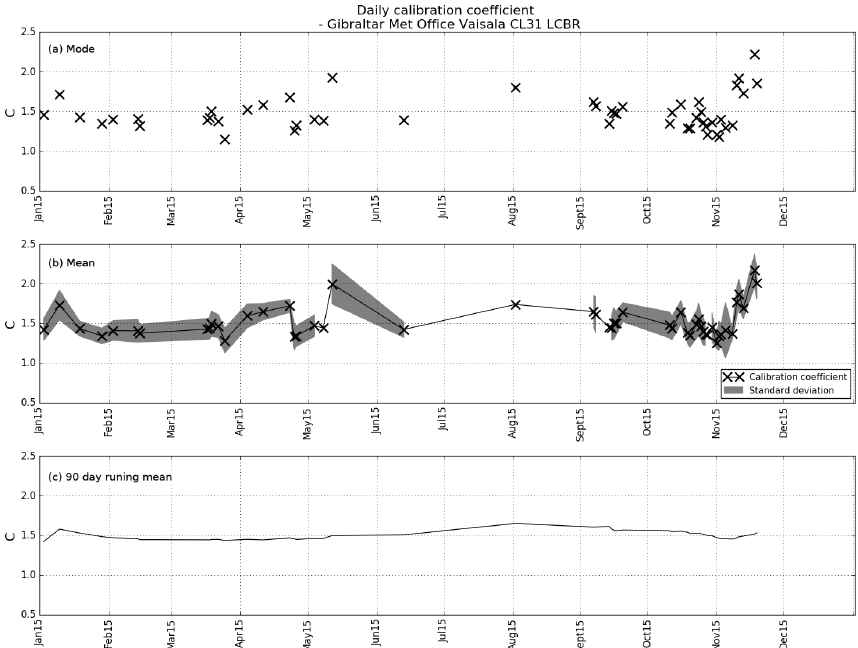
Figure 9. Calibration coefficient ( C ) for Gibraltar CL31 from January to December 2015. Each black cross represents a single day, calculated from profiles deemed suitable by the calibration algorithm. Panel (a) shows the mode of C for each individual day, (b) shows the mean of C for each day, with the standard deviation shaded in grey and (c) shows a 90d running mean for the 12-month period. The average of the daily modes is 1 . 48 ± 0 . 21, the average of the daily means is 1 . 51 ± 0 . 19 and the average of the 90d running means is 1 . 50 ± 0 .